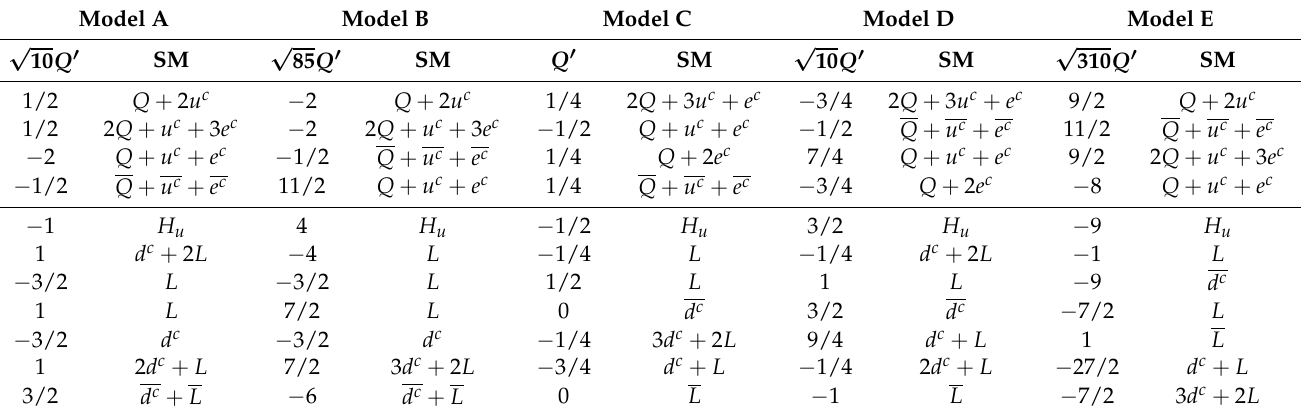
Table 3. The particle content of models A, B, C, D and E using the data from Table 2. Model